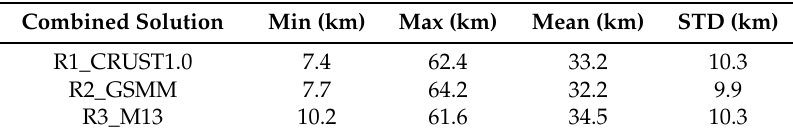
Table 1. Statistics of the Moho depth solutions.